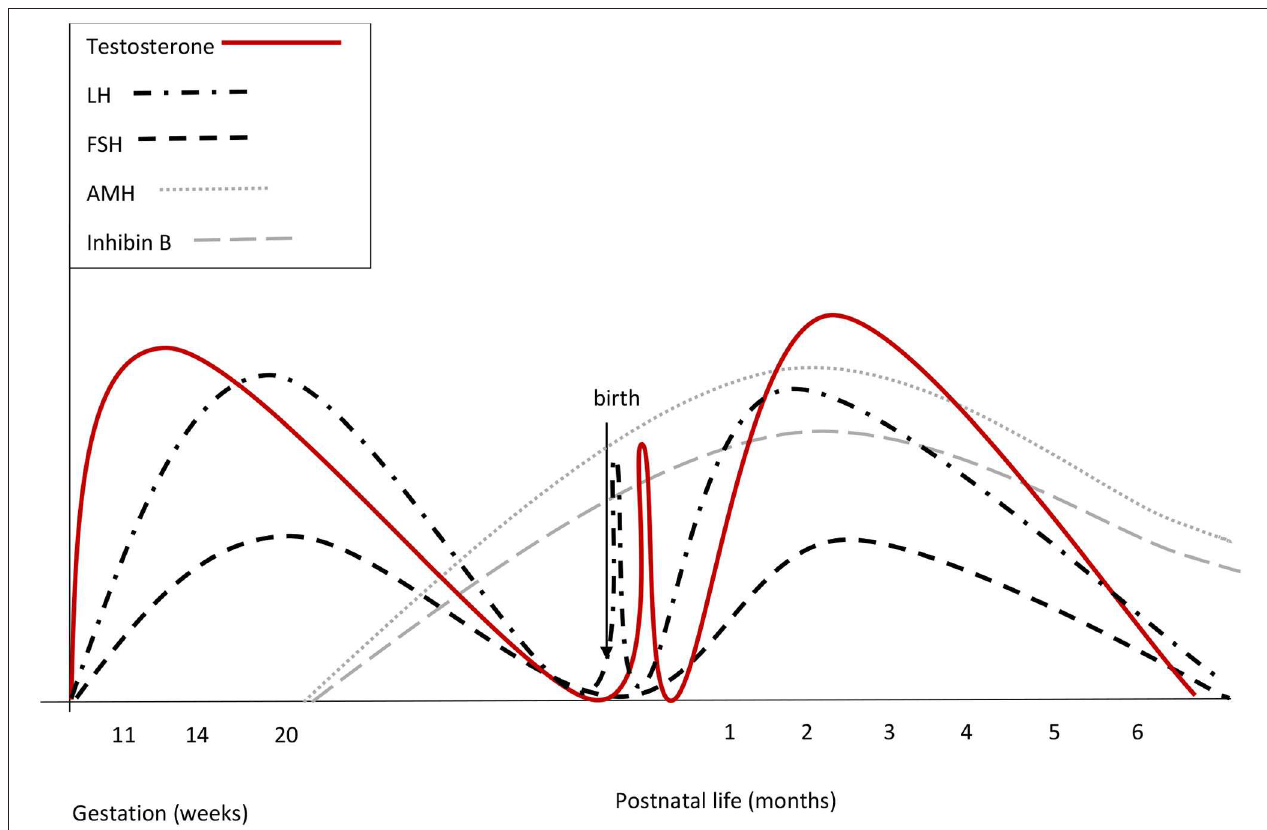
FIGURE 1 | Summary of reproductive hormone changes during early life in healthy boys. Fetal gonadotrophins surge at mid-gestation, then decline and are low or undetectable in cord blood, owing to the inhibitory effect of placental estrogens. Immediately after birth, LH transiently increases by around 10-fold, followed by a testosterone peak, which lasts 12–24h. A few days after birth, gonadotropins surge again. LH peaks between the 2nd and the 10th week of life and then gradually decreases, reaching the low prepubertal values by 6 months of age. FSH drops to the prepubertal range within the 4th month of life. Both at mid-gestation and during minipuberty, LH predominates over